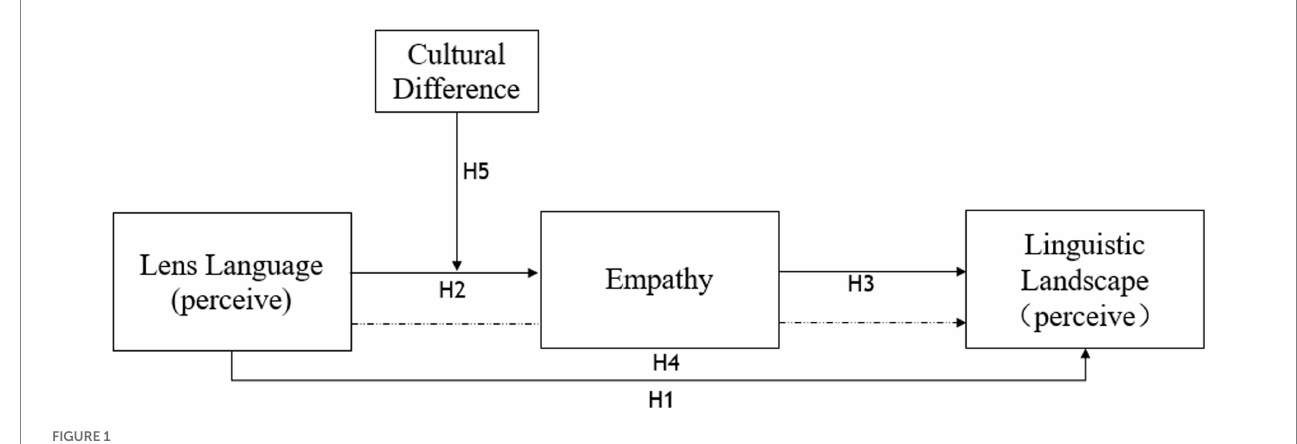
FIGURE 1 Empathy model in movie-induced